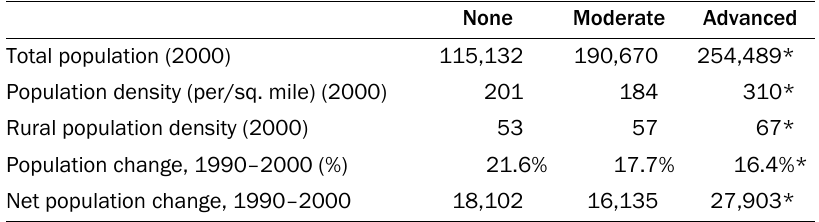
Table 2. Population Demographics by Level of Organization ( N